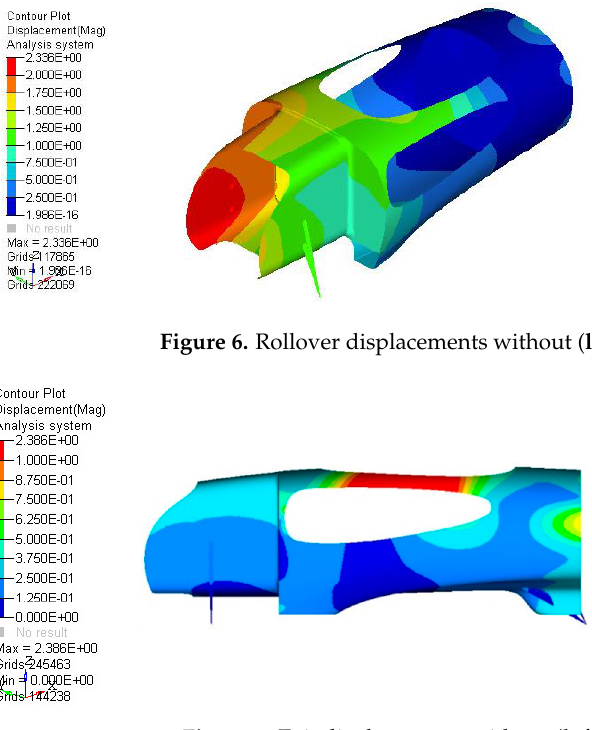
Figure 7. Exit displacements without ( left ) and with ( right ) windows.